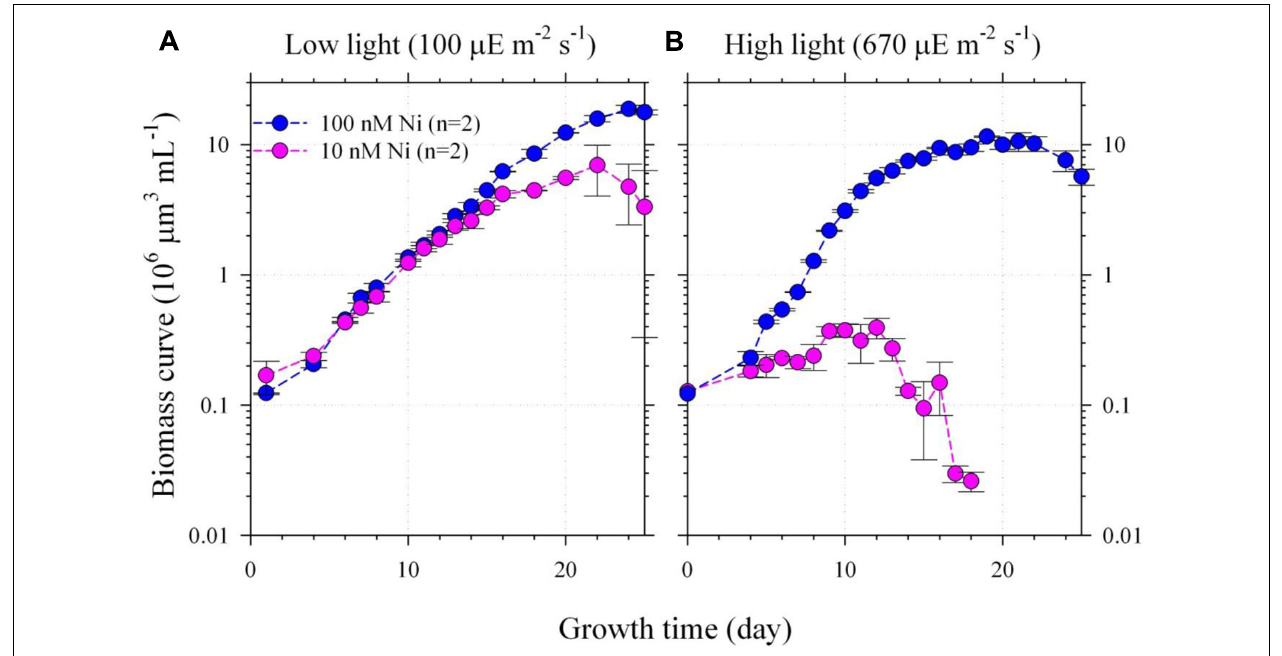
FIGURE 1 |The growth curves of Trichodesmium grown under the low (A) or high (B) light intensities (100 and 670 μ E m –2 s –1 ) and low or high Ni concentrations (10 and 100 nM Ni). The inorganic Ni concentrations for 10 and 100 total dissolved Ni concentrations with 20 μ M EDTA are equivalent to 6.7 and 67 pmol L − 1 correspondingly (Westall etal., 1976).The biomass was presented by cellular volume measured by particle counter.The average deviation of the biomass measurement for duplicate bottles was generally less than 20%.The cellular SOD activities in the two-condition experiment